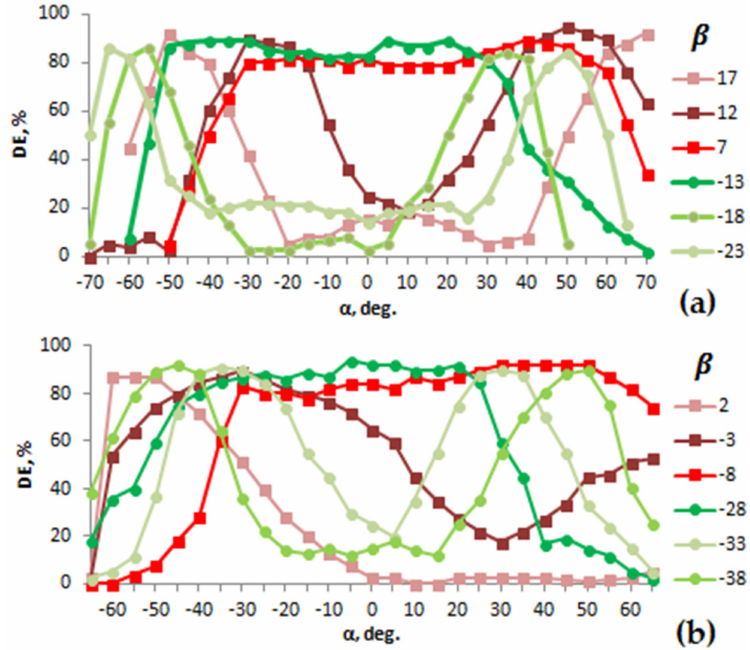
Figure 6. Dependence of diffraction efficiency of slanted gratings on angles α and β , obtained using Scheme 2. The slant angle is of ( a ) 5 ◦ and ( b ) 20 ◦